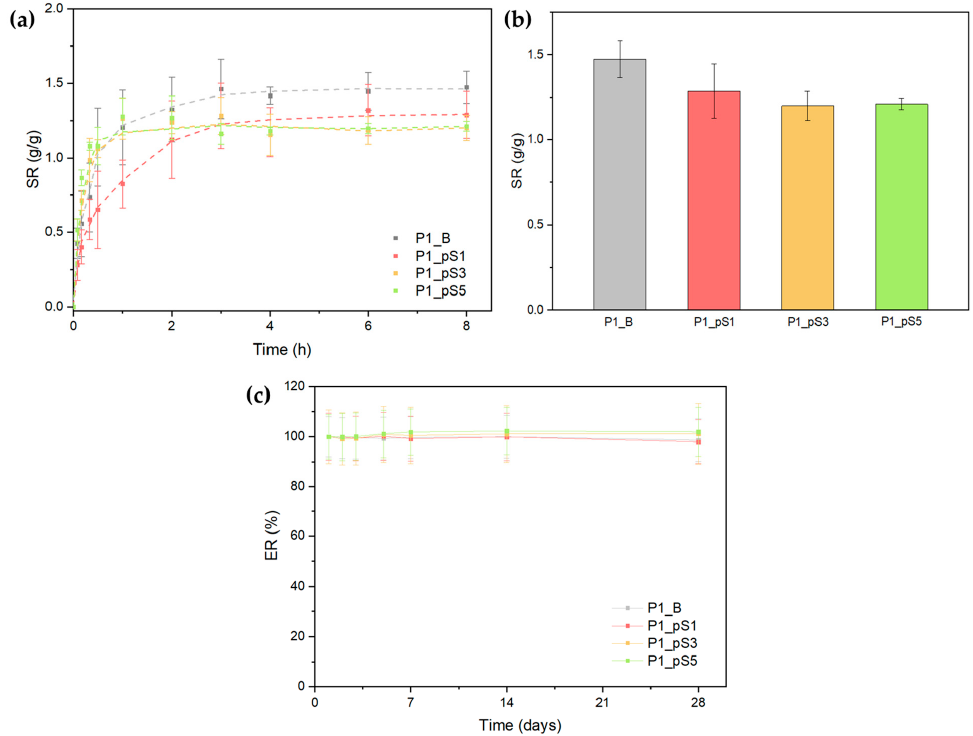
Figure 6. ( a ) Swelling ratio curves for scaffolds without pSPIONs (P1_B (grey)), scaffolds containing 1.92 wt.% of pSPIONs (P1_pS1 (magenta)), scaffolds containing 3.77 wt.% of pSPIONs (P1_pS3 (yellow)), and scaffolds containing 5.54 wt.% of pSPIONs (P1_pS5 (light green)) samples; ( b ) Scaffolds’ swelling ratio after 8h, following the same color scheme; ( c ) Erosion curves for P1_B, P1_pS1, P1_pS3, and P1_pS5 samples, following the same color scheme.